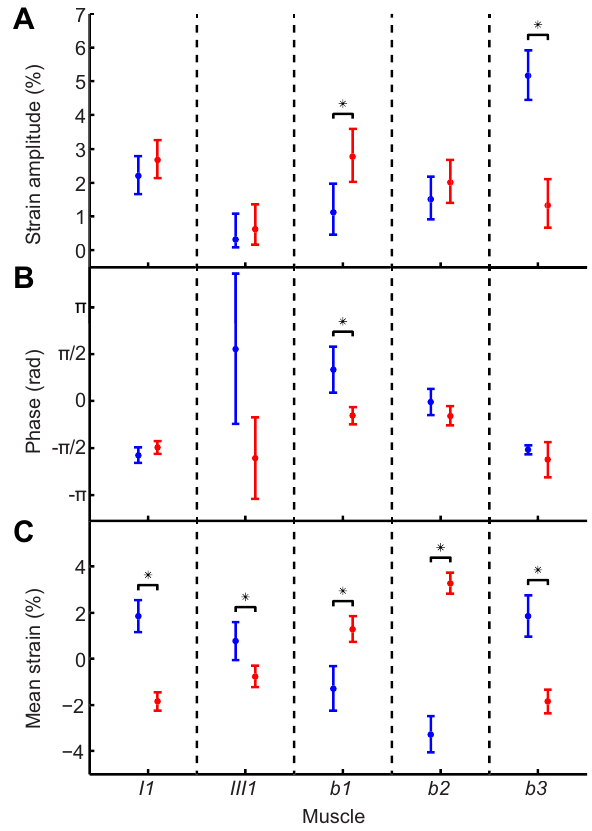
Figure 8. Statistical analysis of steering muscle asymmetries. 95% confidence intervals computed for: (A) amplitude of oscillatory muscle strain, (B) phase of oscillatory muscle strain, relative to start of the downstroke; (C) mean muscle strain. Vertical bars denote 95% confidence intervals; points denote actual parameter estimate. Non- overlapping 95% confidence intervals are starred to indicate the statistically significant differences between the high-amplitude (blue) and low-amplitude (red)